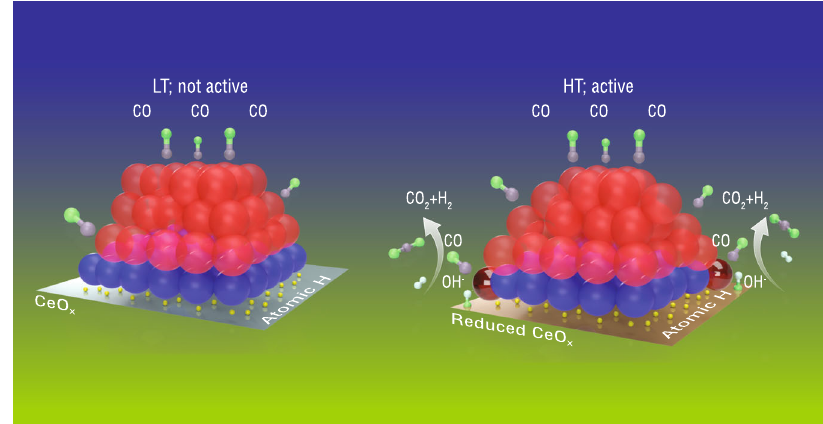
Fig. 7 The schematics of the inactive and active structure of the Pt nanocluster/CeO 2 . At LT (low temperature (LT) < 180 °C), the catalyst is inactive while at HT (high temperature (HT): 180 – 300 °C), the catalyst is active. In the schematics, the red and blue spheres represent Pt atoms that are metallic (zero state) and oxidized (2 + ), respectively. For the active structure, the two maroon spheres represent active perimeter Pt